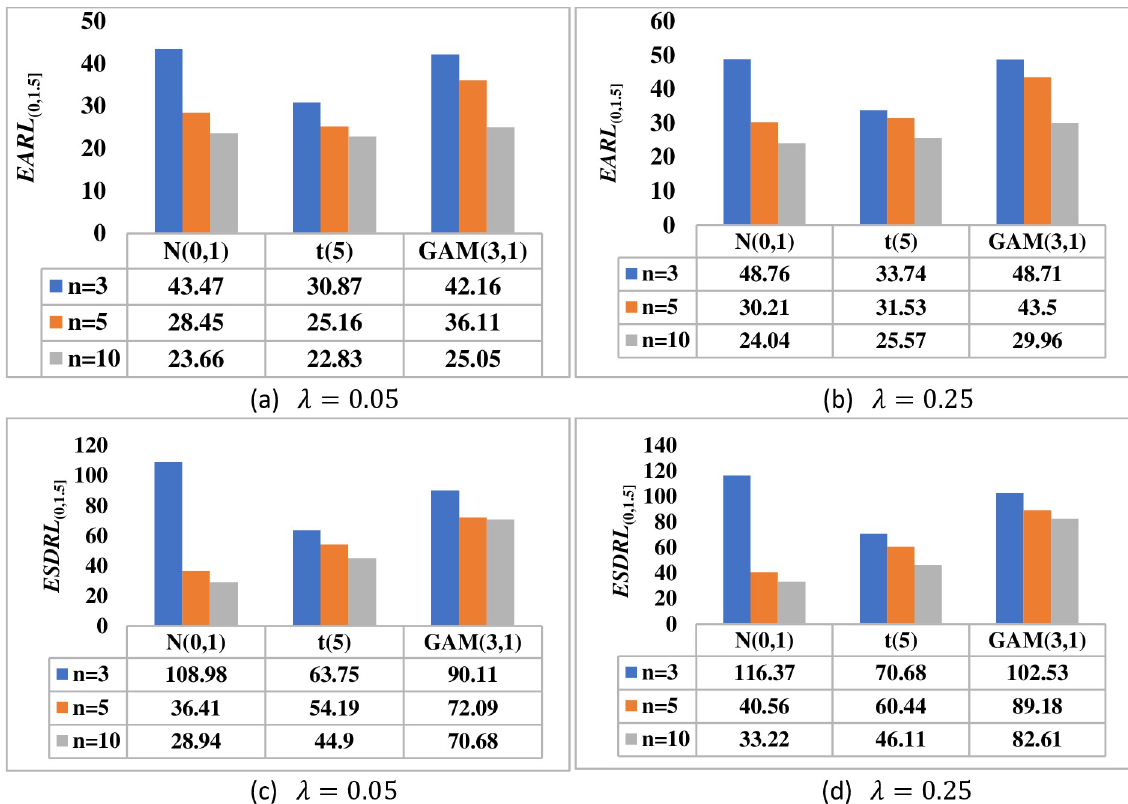
Fig 3. Effect of the phase II sample size on the performance of DHWMA W scheme when m = 100, λ 2 {0.05, 0.25} and n 2 {3, 5, 10} under N (0,1), t (5) and GAM (3,1) distributions.